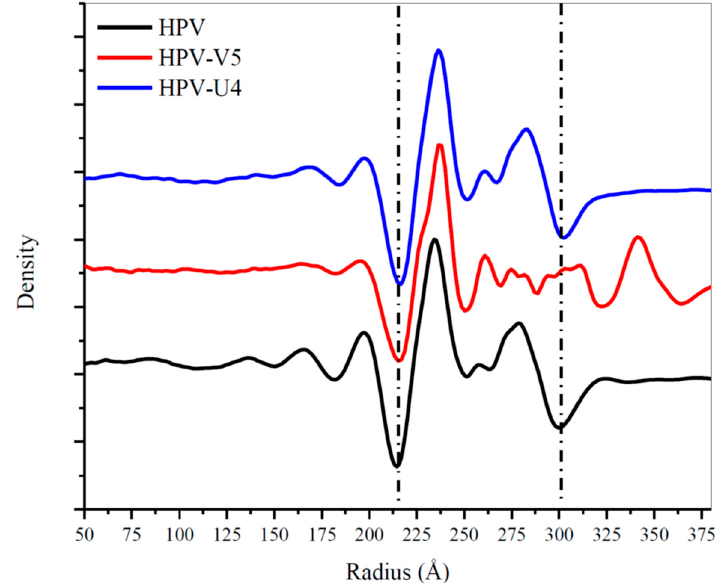
Figure 7. Radial density distributions from center of the map to the edge of the capsid for HPV16 (EMDB-6620) (black), HPV16-V5 (red) and HPV16-U4 (blue) maps. The two dotted lines designate the capsid range.